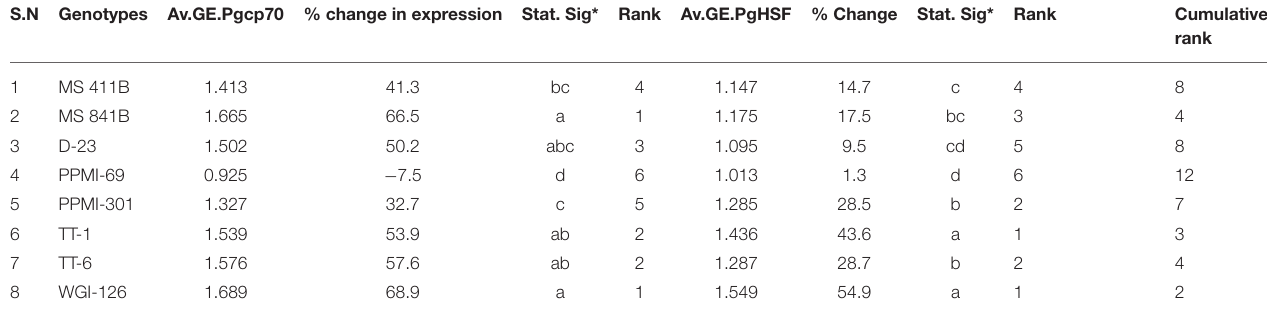
TABLE 5 | Comparison of the relative gene expression level of marker genes at seedling between different pearl millet genotypes under heat stress treatment (with level significance at p ≤